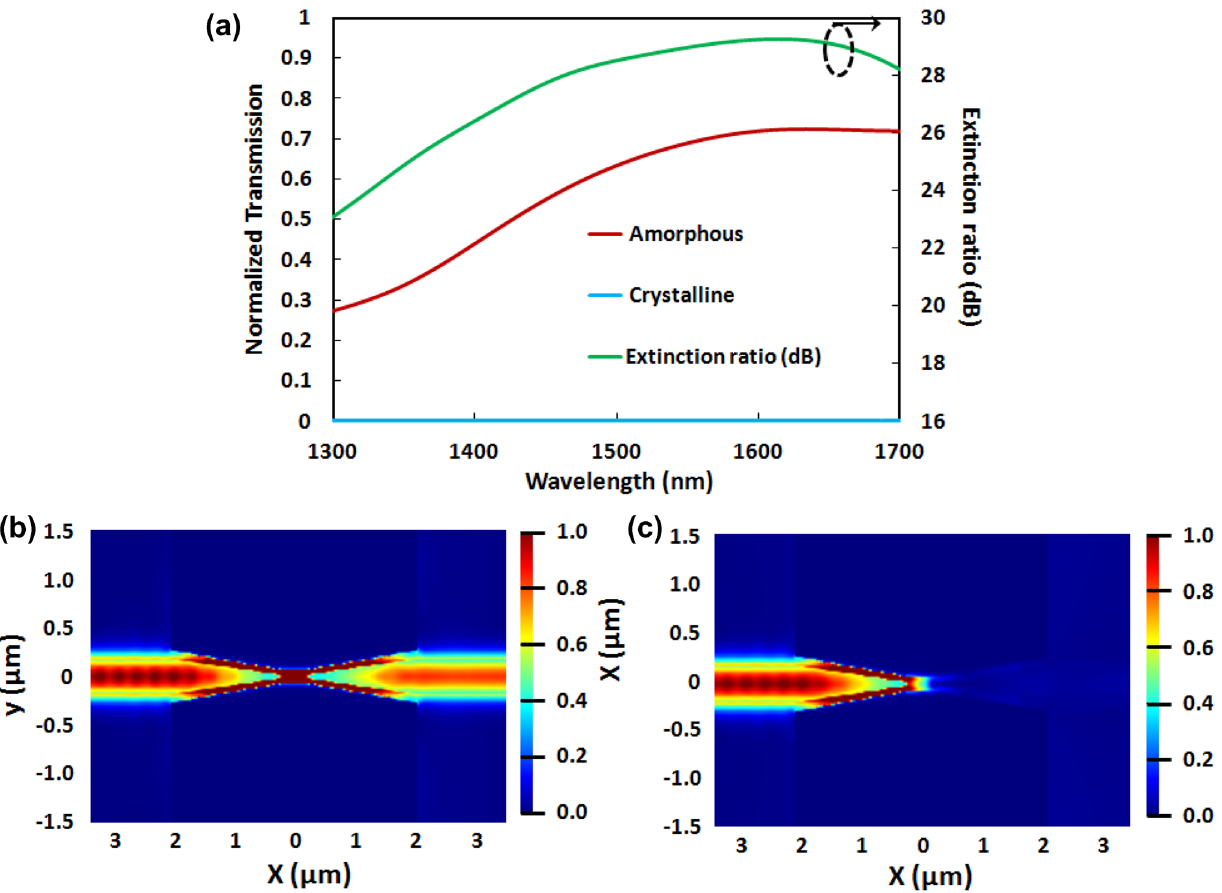
Figure 2. ( a ) The transmission spectra of the non-volatile hybrid electro-optic plasmonic switch for both phases of the GST layer and the extinction ratio of the proposed broadband electro-optic modulator. The optical electric field distributions of the hybrid plasmonic switch at a wavelength of 1550 nm for ( b ) the amorphous phase and ( c ) the crystalline phase. The transmission spectra and field profiles were calculated for TE polarization of light. The following optimized geometrical parameters are chosen for the plasmonic switch—the cross-section of the Si waveguide was taken to be 500 nm × 220 nm, the length of the tapered waveguides was taken to be 2 µm, the taper angle (‘θ’) was taken to be 25°, the height of the metal ’h’ was taken to be 220 nm, the width of the slot ’w’ was taken to be 180 nm, the thickness of the PCM layer ’t’ was taken to be 20 nm, and the length of the slot waveguide was taken to be 500